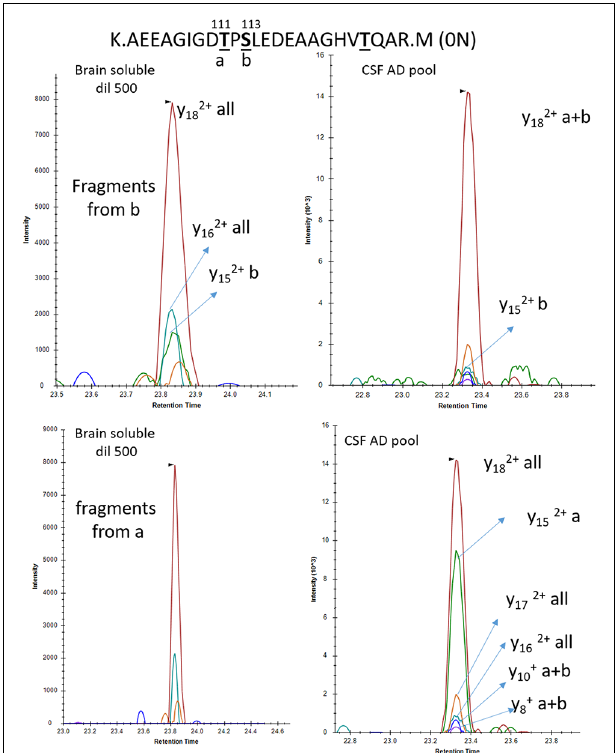
FIGURE 10 | Phosphorylation abundance on T111 is higher in the CSF than the brain relative to S113 phosphorylation. In both brain and CSF, the MS/MS fragment y18 common to all mono-phosphorylated peptides on tau sequence 103–126 is detected. The relative abundance of the y15 fragment from pS113 (b) is significantly lower in CSF in comparison to brain extract. Inversely the y15 fragment from pT111 (a) is abundant in CSF and not detectable in brain soluble extract diluted to match the AD CSF tau